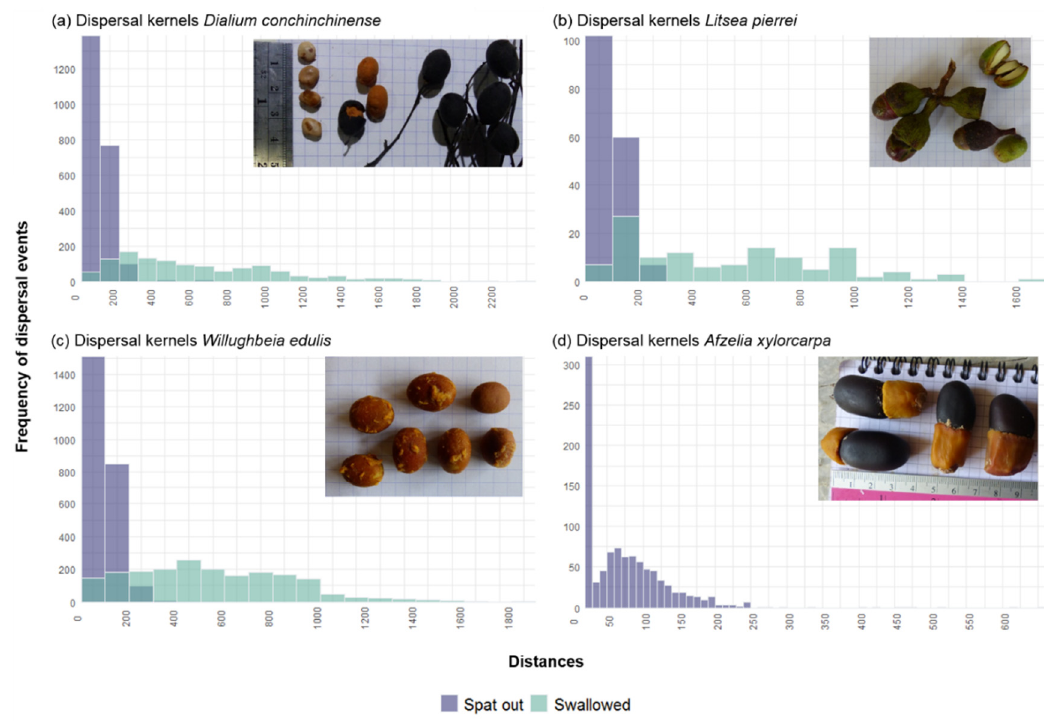
Figure 4. Simulated dispersal kernels for swallowed and spat out seeds in four plant species consumed by the northern pigtailed macaques in Sakaerat: ( a ) Dialium conchinchinense, ( b ) Listea pierrei , ( c ) Willughbeia edulis and ( d ) Afzelia xylocarpa . Note: The dark green color is the result of the juxtaposition of the spat out and swallowed dispersal kernels.